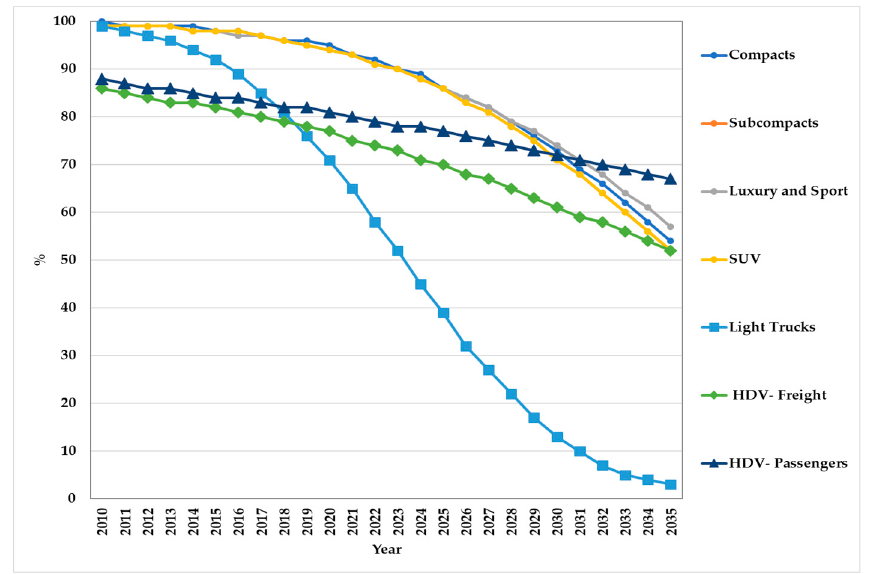
Figure 1. Survival curves by vehicle type. Source: [26].